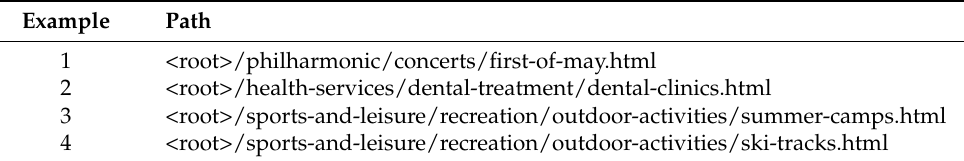
Table 1. Path examples from an example municipal